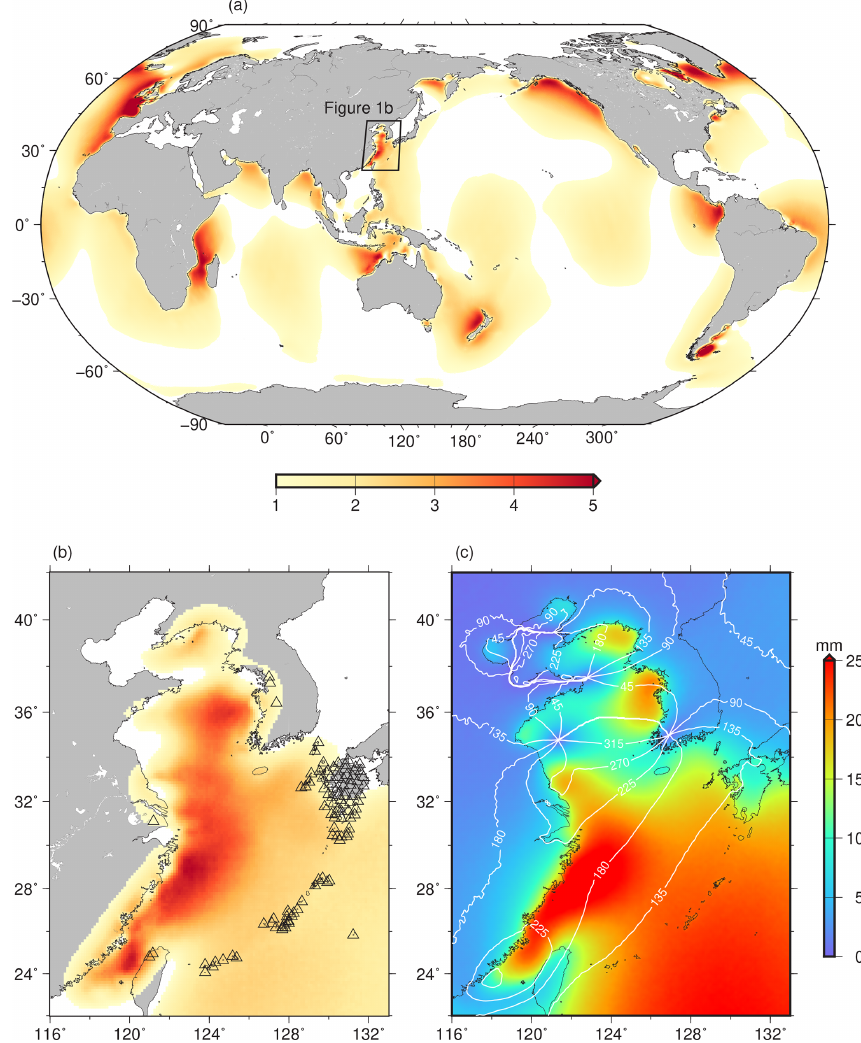
Figure 1. (a) Global distribution (1 / 8 ◦ grid) of M 2 “detectability ratio” of the difference between vertical OTL displacements predicted using purely elastic and anelastic Green’s functions, to uncertainty in residual OTL displacements predicted using eight ocean tide models and the GPS observational error. (b) Detectability ratio in the East China Sea (ECS) region, showing the GPS sites used in this study as triangles. The colour scale is the same as in (a) . (c) The M 2 vertical OTL displacement amplitudes and Greenwich phase lags for a 1 / 8 ◦ grid across the ECS region using the FES2014b ocean tide model and an elastic PREM Green’s